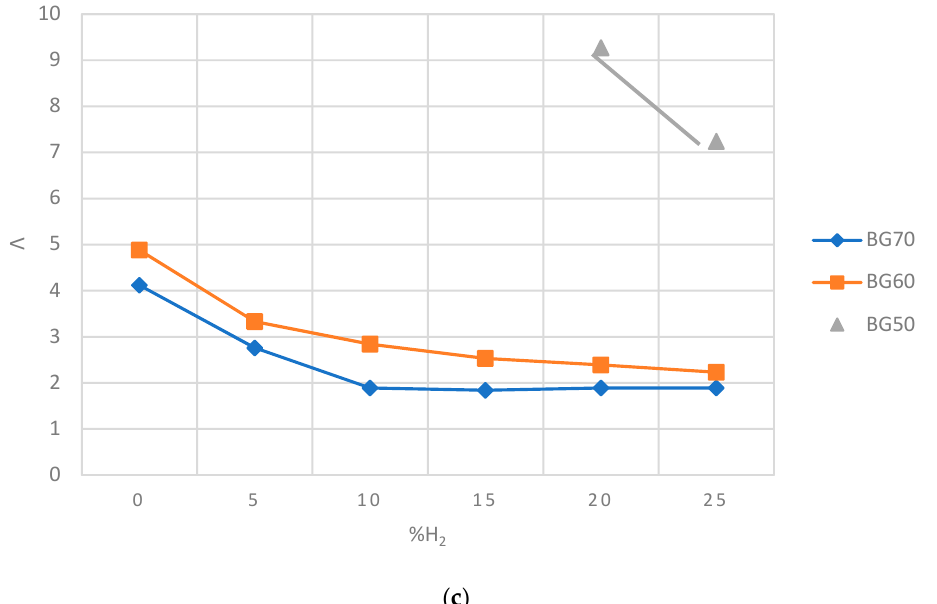
Figure 11. Exhaust gas variations due to hydrogen addition: ( a ) influence of O 2 addition to CO 2 emissions; ( b ) influence of O 2 addition to O 2 emissions; ( c ) influence of O 2 addition to combustion lambda.